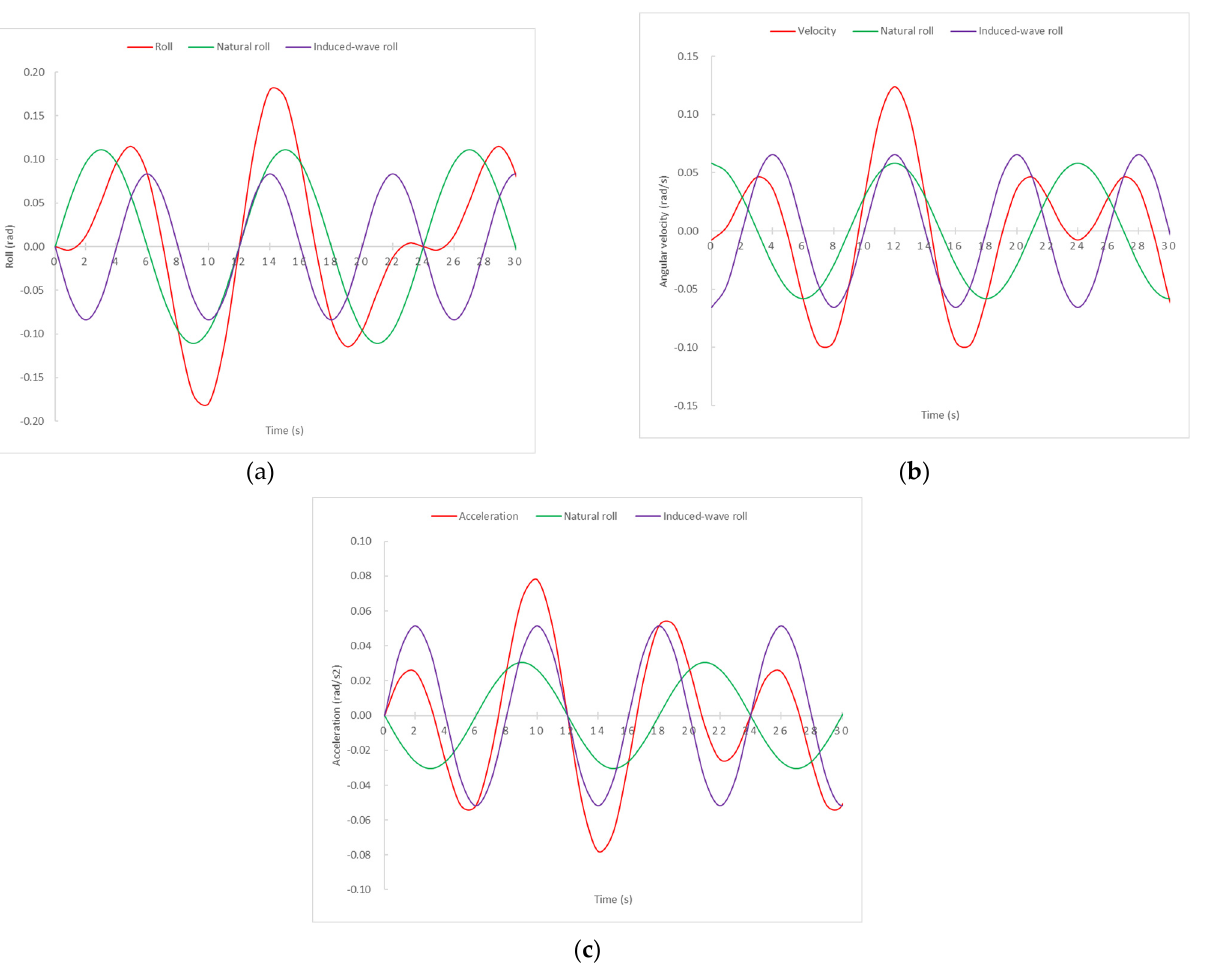
Figure 4. Rolling angle ( a ), velocity ( b ) and acceleration ( c ) of a ship with a Td = 12 s sailing in waves of Tw= 8 s.